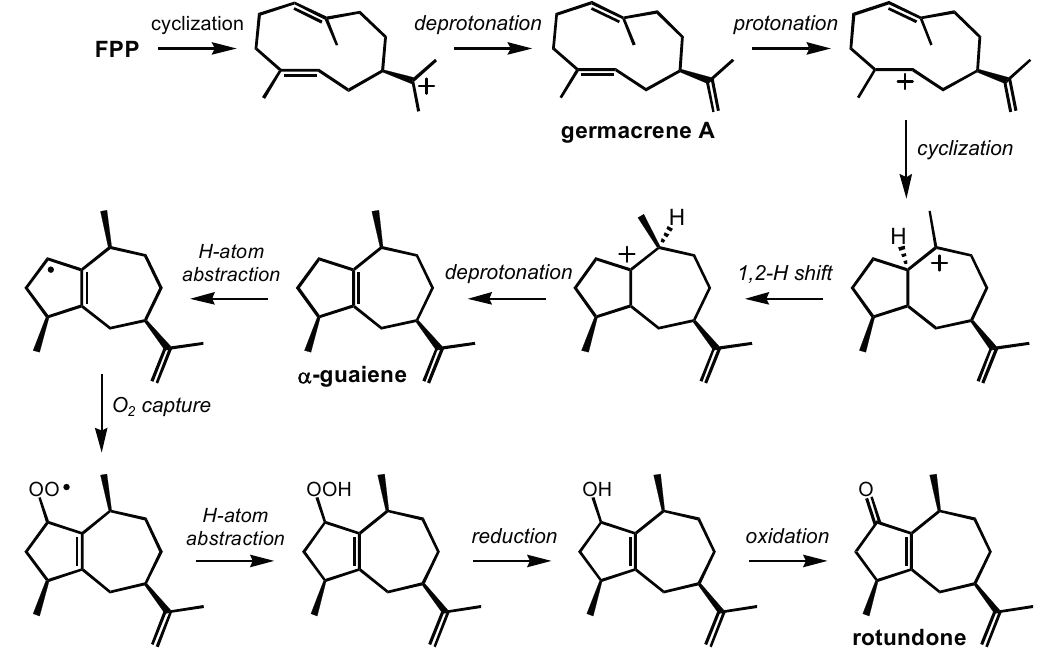
Scheme 4. Proposed biosynthetic formation of rotundone: α -guaiene-forming carbocation cascade followed by radical-initiated